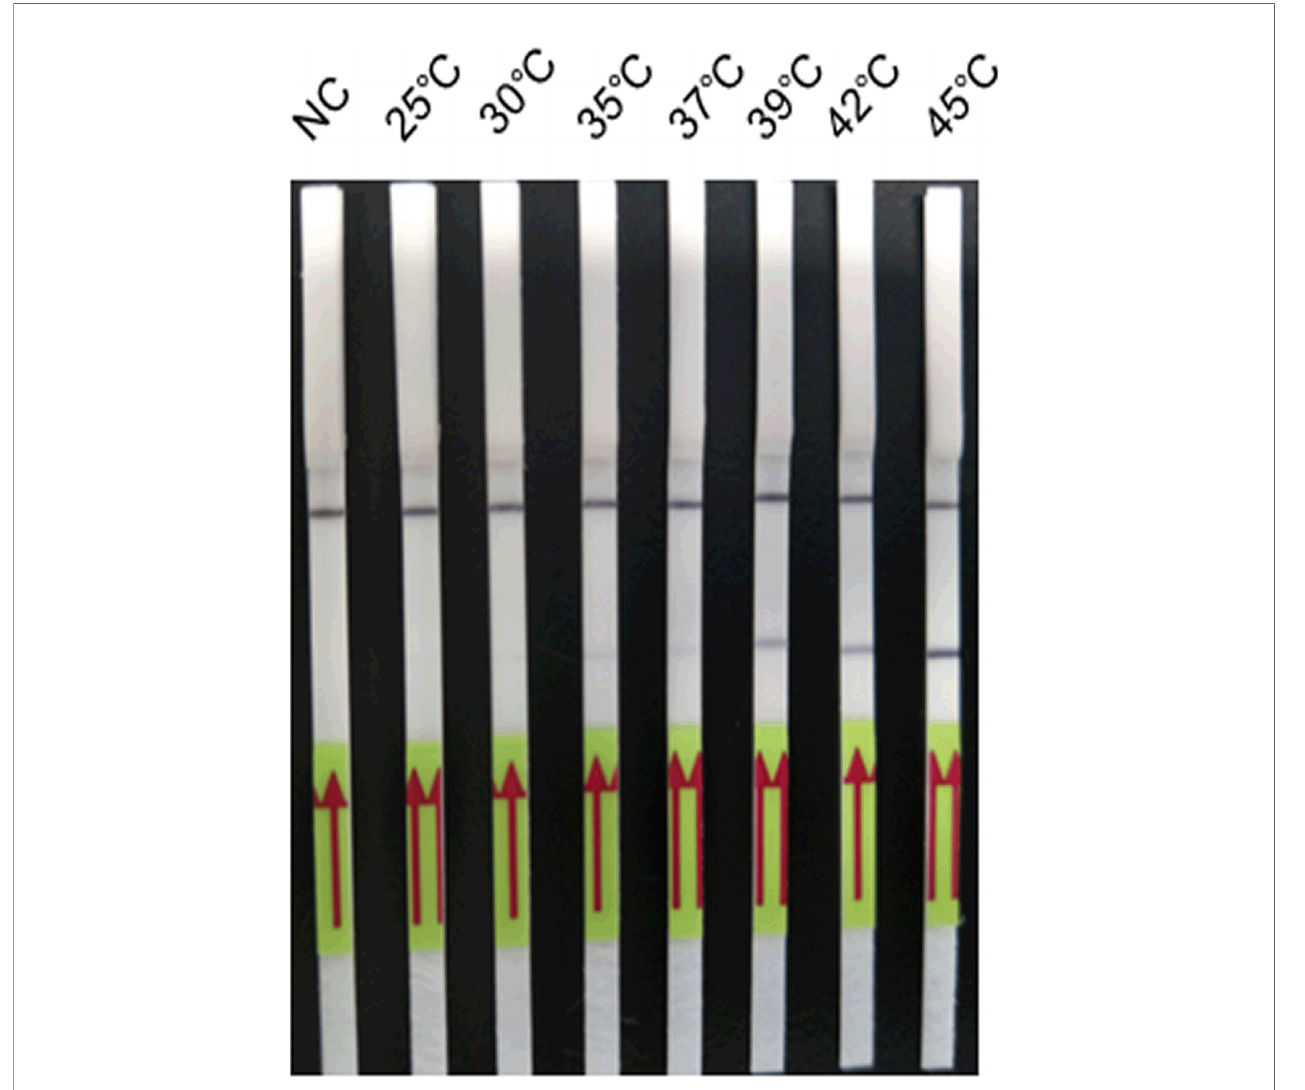
FIGURE 2 | Optimisation of the ampli fi cation temperature of the LFD-RPA assay. The LFD-RPA assay results are positive over a wide range of temperatures from 35°C to 45°C. The samples of 25°C – 45°C were all 2.6 fg/ m l positive plasmid. Negative control (NC), DNA extracted from negative samples and ampli fi cation at 45°C. The red arrows stand for the direction of reaction solution diffusing in the lateral fl ow